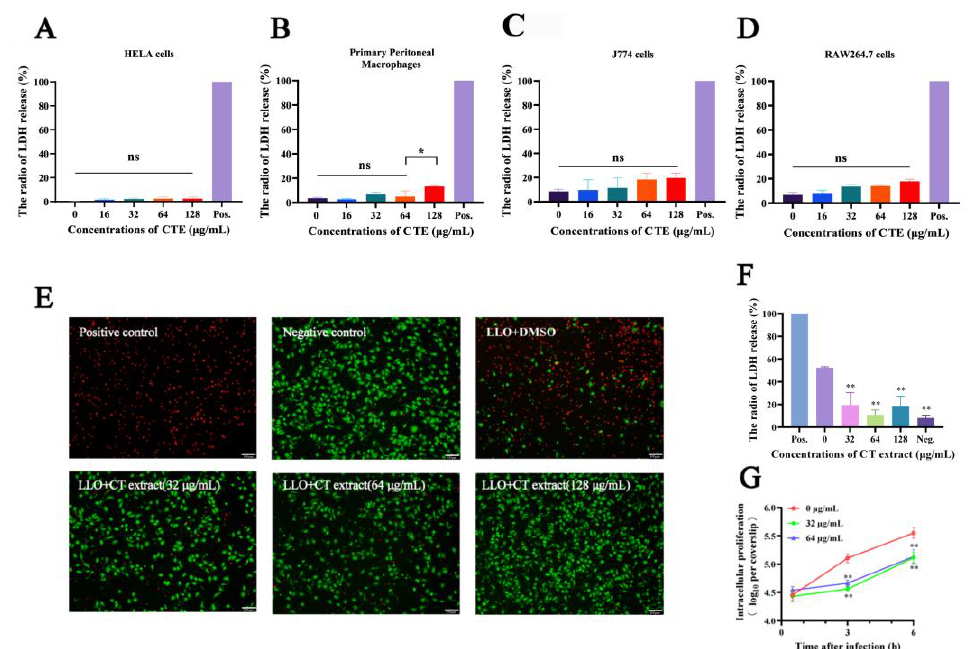
Figure 2. CT extract decreased L. monocytogenes -induced cellular injury in a dose-dependent manner. Cytotoxicity of CT extract on HeLa cells ( A ), the primary periodontal macrophages ( B ), J774 cells ( C ) and RAW264.7 cells ( D ). Cytotoxicity was determined by relative lactate dehydrogenase (LDH) release following a 6 h incubation with the indicated concentrations of CT extract. Triton-X 100 at a concentration of 0.2% served as a positive control and no treatment as a negative control. ( E ) The viability of L. monocytogenes -infected RAW264.7 cells was assessed with a LIVE/DEAD ® kit following the indicated treatment. Then cells co-cultured with LLO + DMSO and 32 μg/mL, 64 μg/mL and 128 μg/mL of CT extract were used to assess cell viability. Triton-X 100 at a concentration of 0.2% served as a positive control and no treatment as a negative control. These images were collected from an original magnification of 40 × (the scale length is 100μm) ( F ) Cell cytotoxicity induced by LLO in the presence of the indicated concentrations of CT extract was measured by LDH release assay. Cells treated with 0.2% Triton-X 100 or no treatment served as the positive control and negative control, respectively. ( G ) Inhibition of intracellular bacterial growth by CT extract (32 and 64 μg /mL). RAW264.7 macrophages were infected with overnight-cultured L. monocytogenes EGD at an MOI of 10. The macrophages were lysed at the indicated time points to determine the numbers of total CFU. * p < 0.05 and ** p < 0.01 compared to the positive group. ns, not